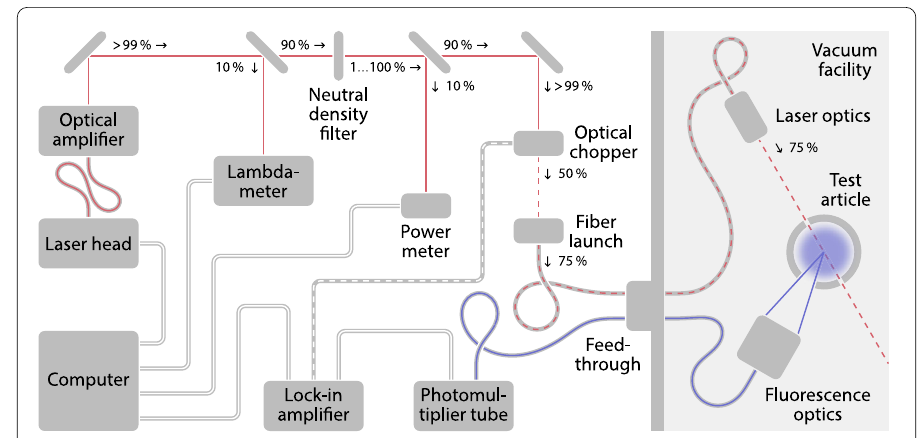
Figure 4 Schematics of the LIF setup. Optical transmissions or reflectances of each element placed in the laser beam path are denoted, optical fibers are visualized by curved lines